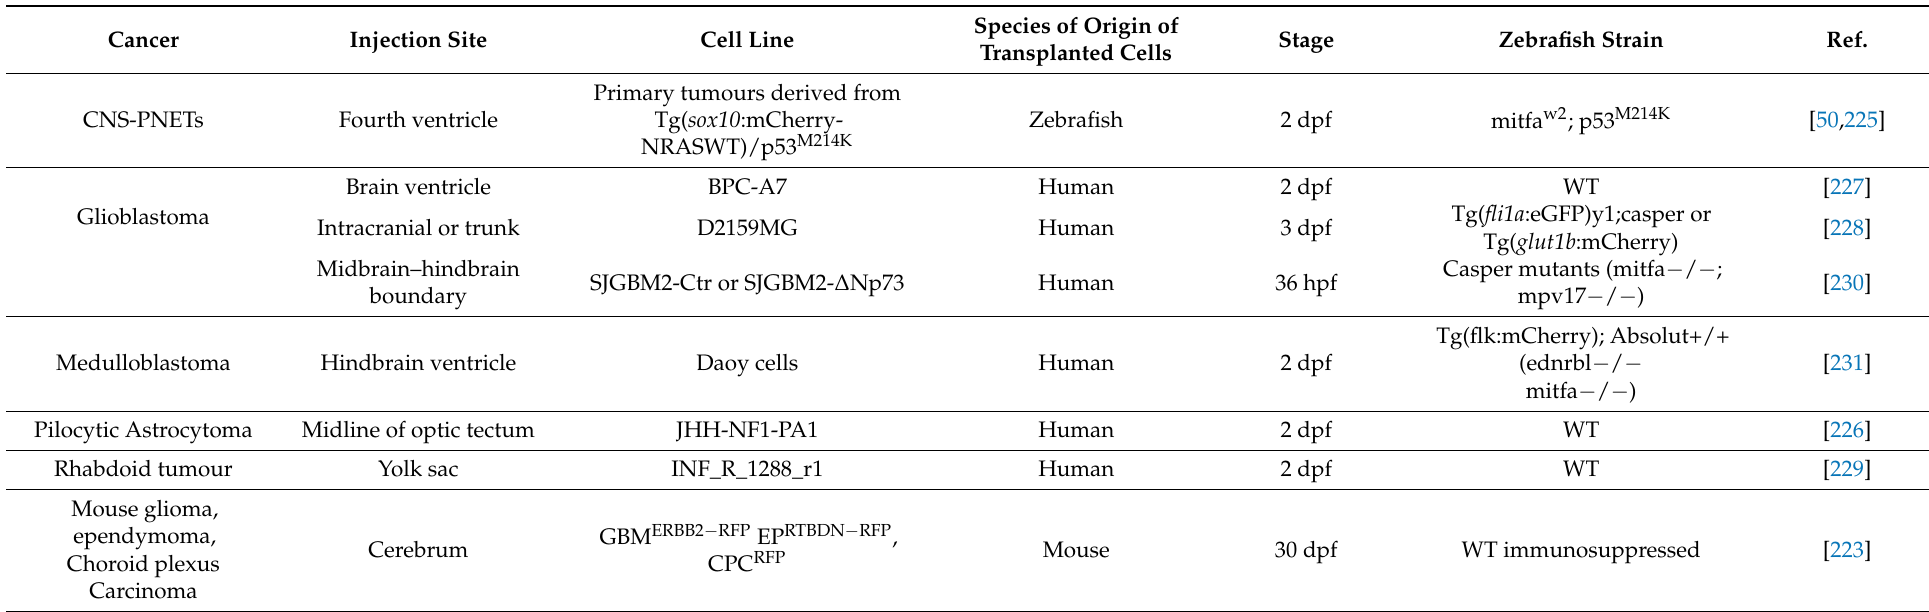
Table 2. Transplantation models of paediatric brain tumours in